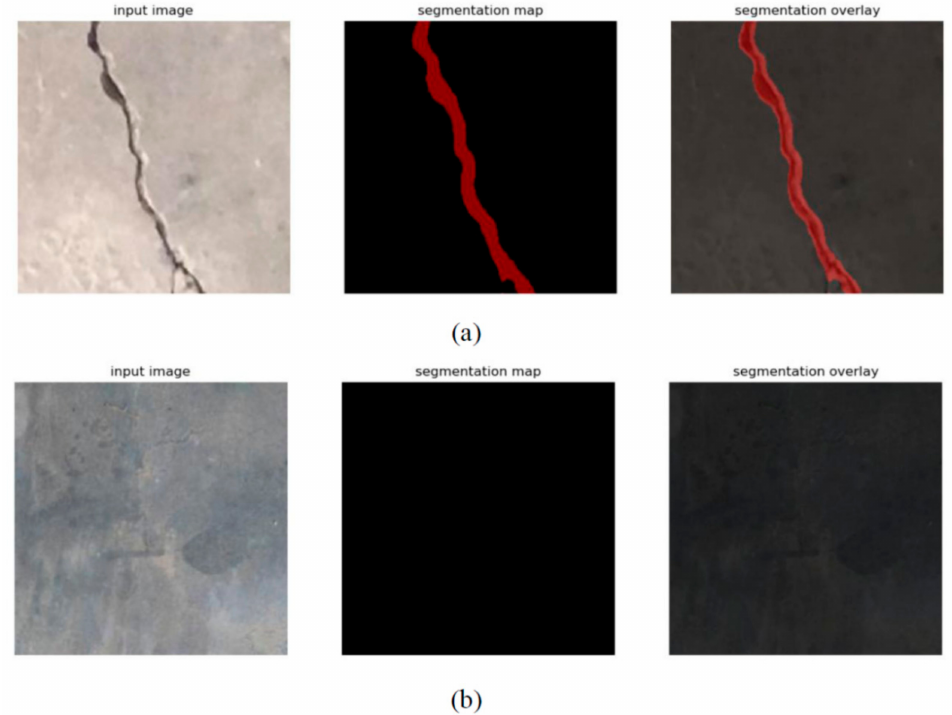
Figure 10. Validation results of crack images ( a ) and background images ( b